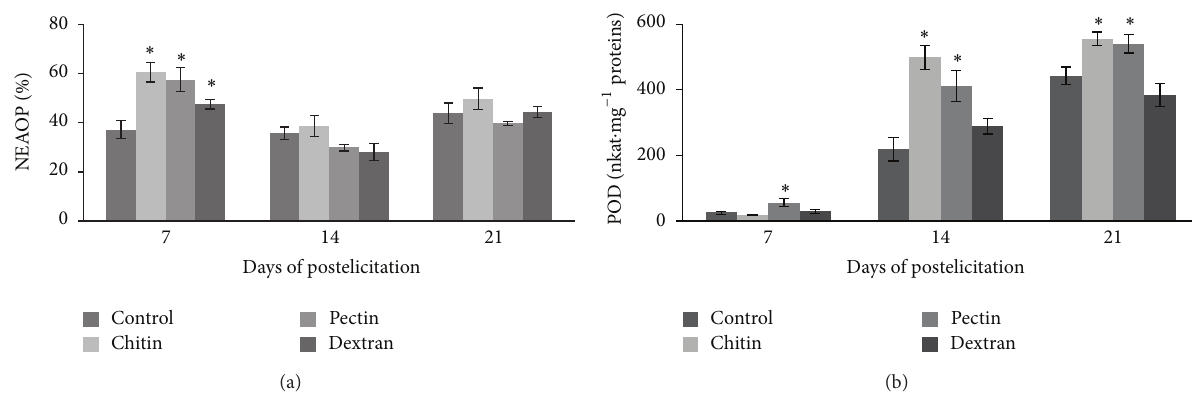
Figure 2: Effects of polysaccharide elicitors on (a) nonenzymatic antioxidant properties and (b) peroxidase activity in Hypericum perforatum shoot cultures. NEAOP: nonenzymatic antioxidant properties; POD: peroxidase. Level of significance is ∗ 𝑃 < 0.05